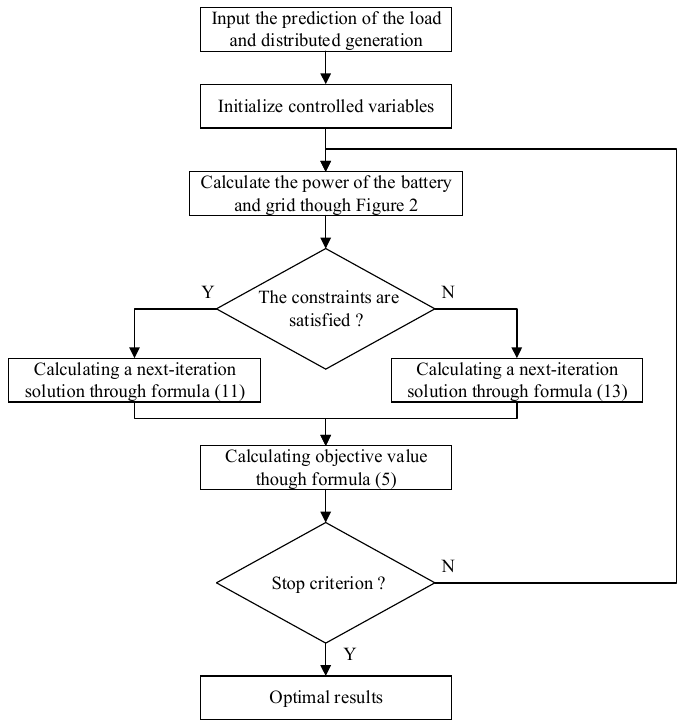
Figure 3. Flowchart of the PSO process.